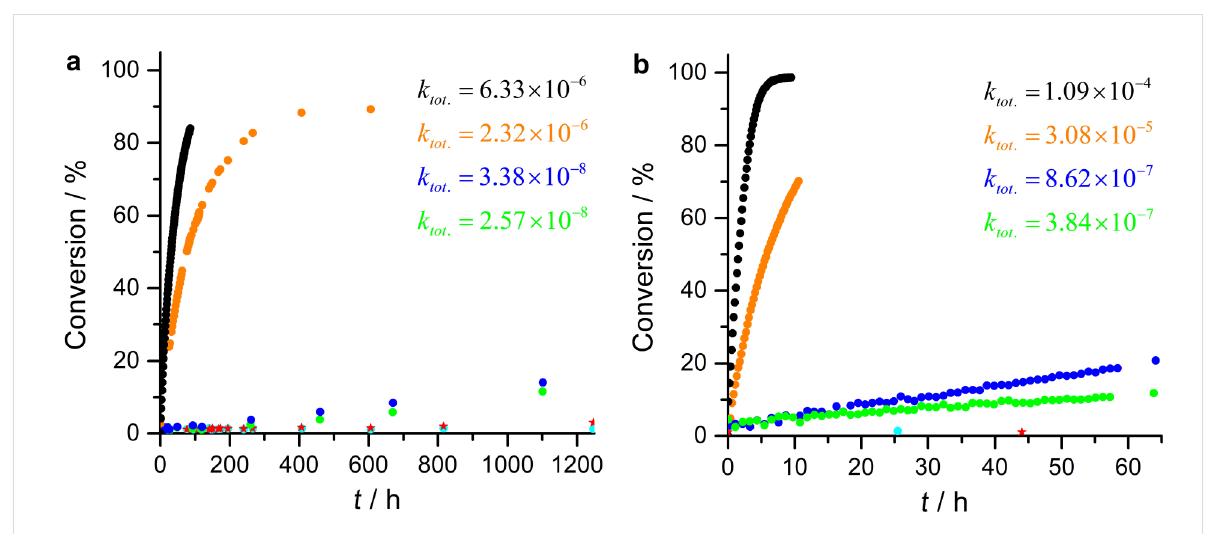
Figure 4: Conversion of 4-nitrobenzaldehyde ( 6 ) in the Henry reaction with nitroethane ( 5 ) as a function of time, using (a, left) 4 mM concentration of catalyst or reference compound (1 mol % compared to 4-nitrobenzaldehyde) or 40 mM catalyst (10 mol % compared to 4-nitrobenzaldehyde) (b, right). Rate constants ( k tot ) are given for DMAP ( 2 ) (black dots), azopyridine trans- 4 (orange), photoswitchable porphyrin 1 at PSS 435nm (predominant- ly trans- 1 , blue), and 1 at PSS 530nm (predominantly cis- 1 , green). The background reaction was determined with porphyrin 8 (cyan dots) and for a sample without catalyst or reference compounds (red